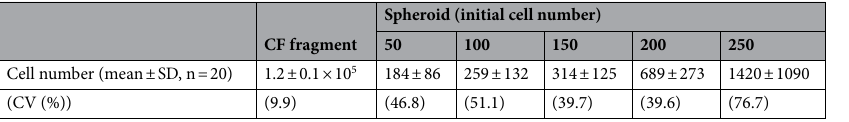
Table 1. Cell numbers of GT1-7 CF fragment and GT1-7 spheroids. GT1-7 CF fragments and GT1-7 spheroids made with the different initial cell numbers (50, 100, 150, 200, 250 cells) were cultured for 11 days. The numbers of cells in CF fragments and spheroids were